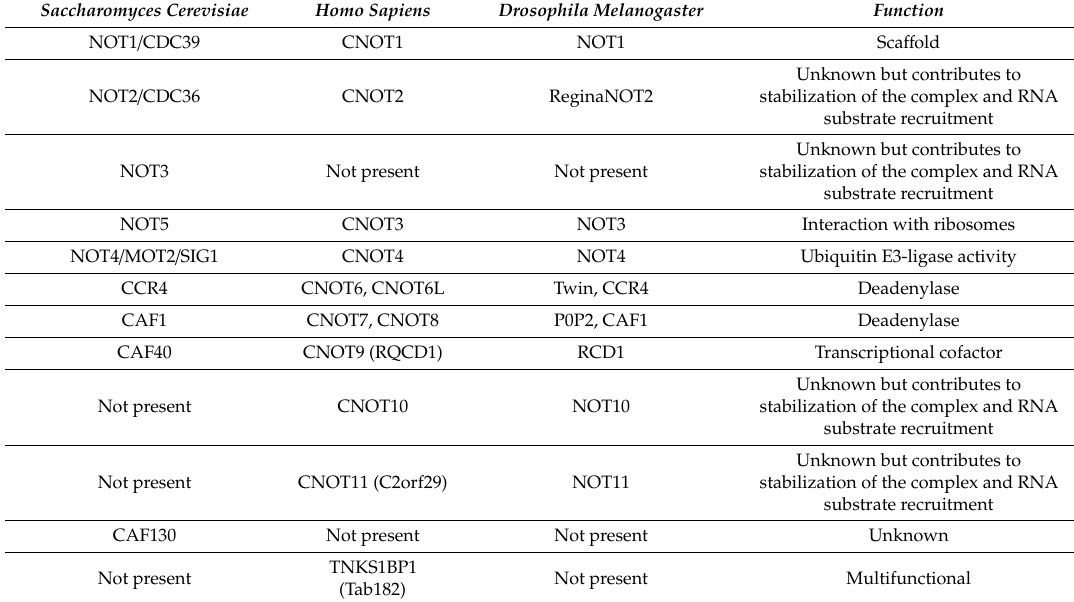
Table 1. A list of alternative names for equivalent CCR4–NOT complex subunits from Saccharomyces cerevisiae (baker’s yeast), Homo sapiens (human) and Drosophila melanogaster (fruit